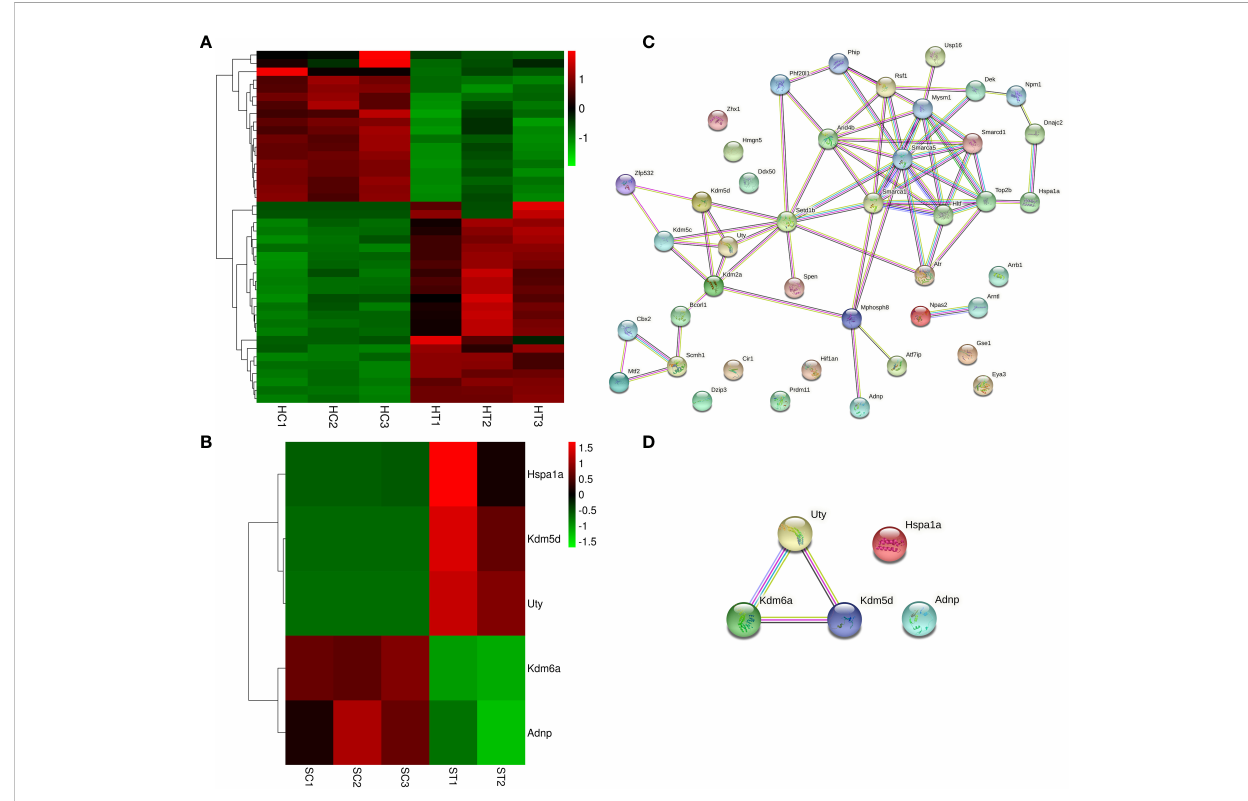
FIGURE 5 ART affects the expression of epigenetic modi fi ers in the heart and spleen of offspring. (A, B) Heatmap showing the effect of ART on the expression of epigenetic modi fi ers in the heart and spleen tissues of the offspring, respectively; (C, D) STRING analysis revealed the interaction between aberrantly expressed epigenetic modi fi ers in heart and spleen tissues of ART offspring,